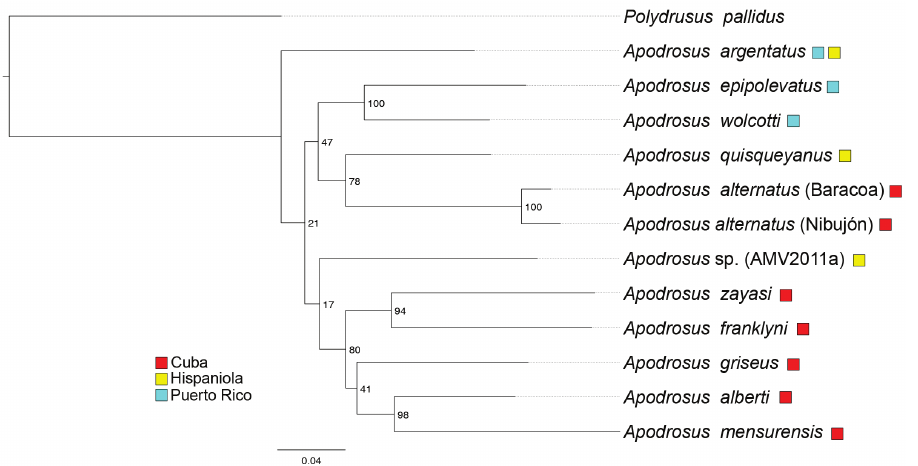
Figure 28. Maximum likelihood phylogeny of Apodrosus , based on six gene fragments. Colored boxes indicate species distributions. Bootstrap support values (1000 replications) are drawn at nodes. Hispaniola is represented by the Dominican Republic for all instances. Scale bar indicates the average number of nucleotide substitutions per